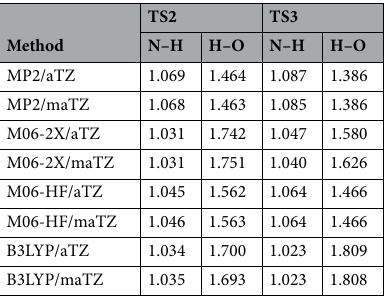
Table 1. Bond lengths (in Å) for TS2 and